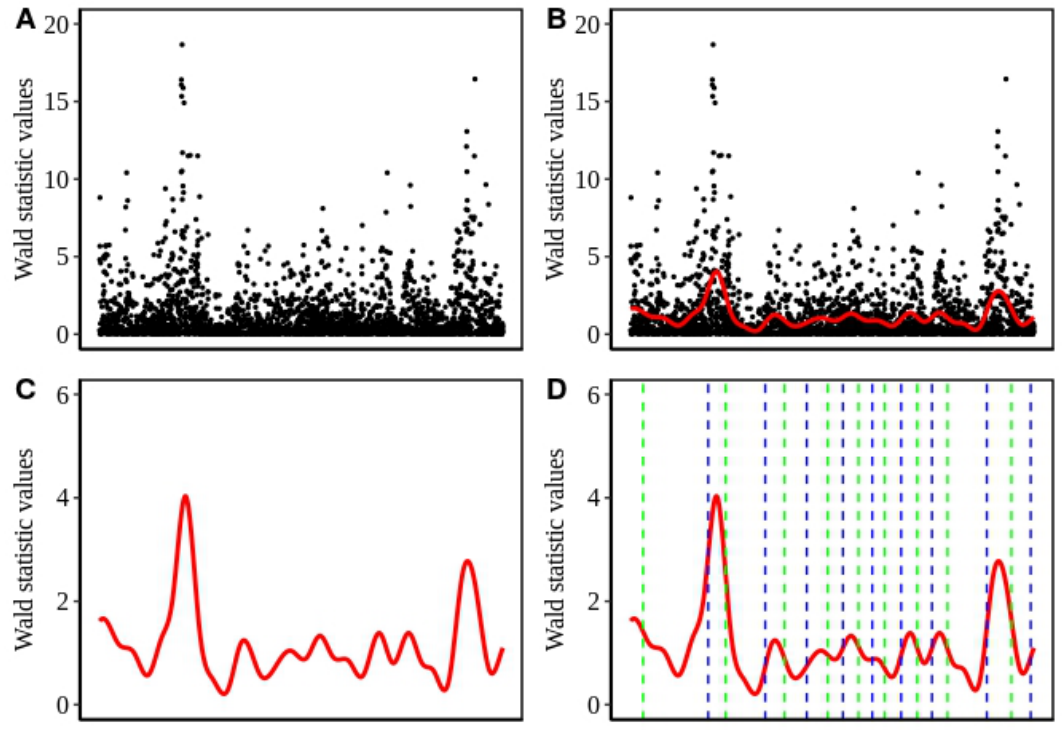
Figure 1. Step by step representation of the peak detection method. ( A ) Distribution of the test statistic values along the length of a chromosome segment. ( B ) The red line indicates the cubic spline fitted on the test statistic values represented by the black dots. ( C ) The same cubic spline curve as in B without points, y-axis rescaled ( D ) Dashed lines represent the inflection points of the curve. A pair of a left (blue) and a right (right) inflection point constitute a peak. An analogous suite of displays is shown in [54] to present the partitioning of genomic data into